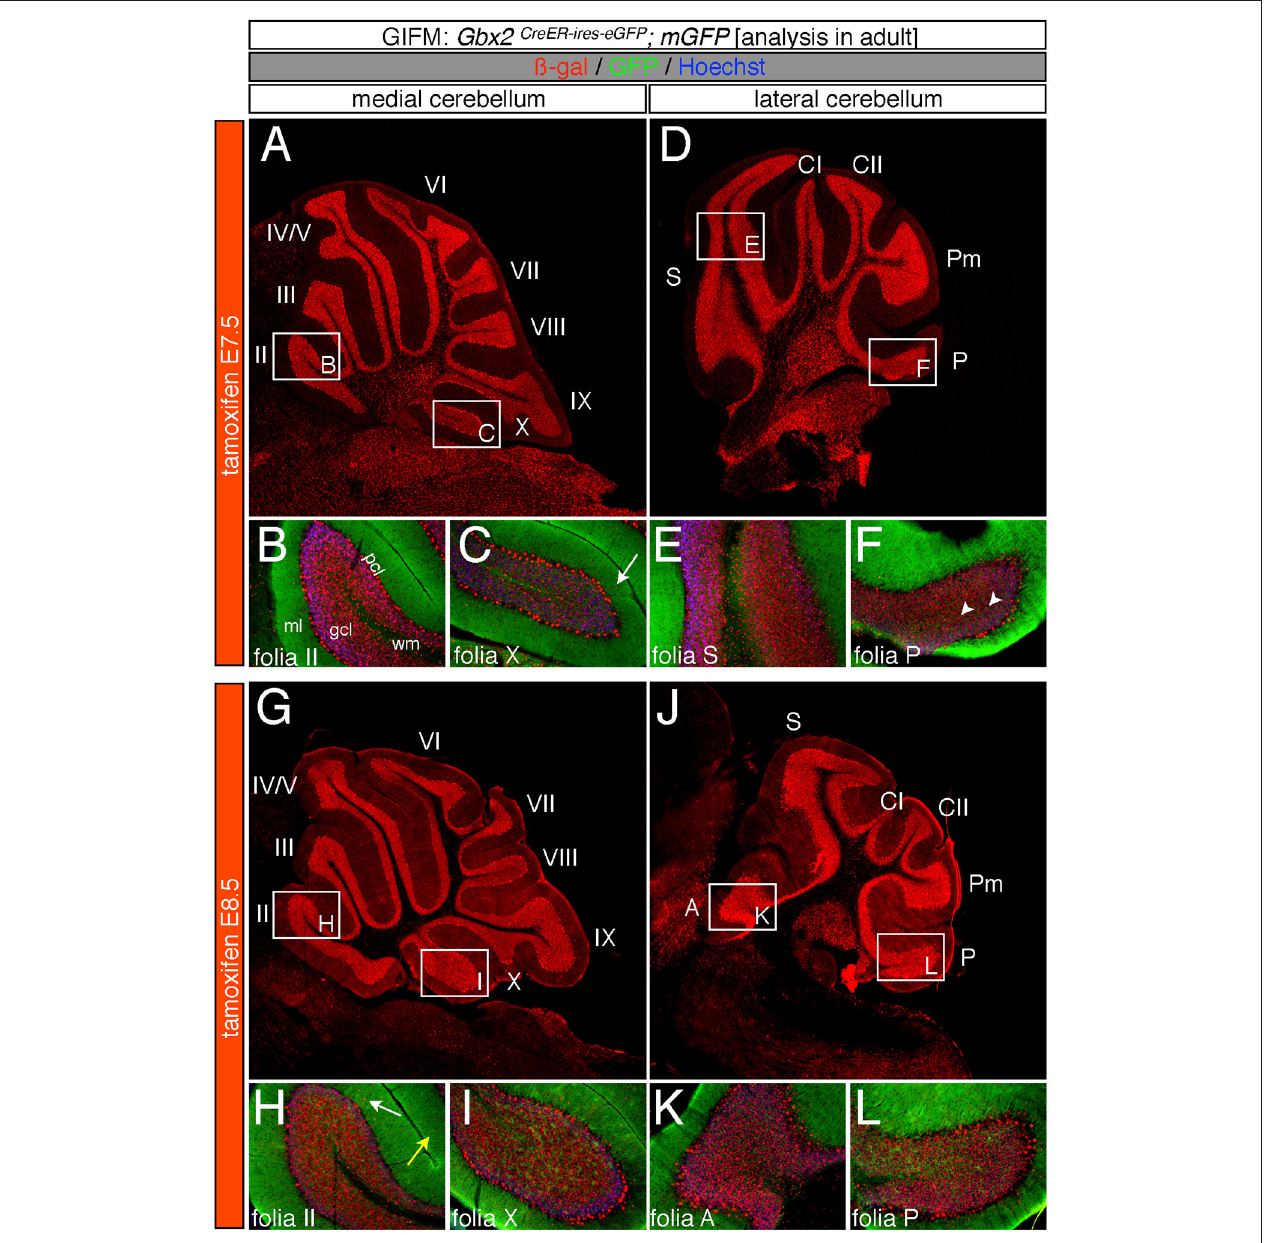
FIGURE 3 | Spatial and temporal contribution of the early marked Gbx2 lineage to the mature Cb. ICC on adult sections with antibodies that recognize ß-gal (red) or GFP (green) revealed that early Gbx2 expressing progenitors give rise to cells throughout the Cb cortex. (A–F) Gbx2 expressing progenitors marked at E7.5 substantially contributed to granule cells. Medially, Gbx2 -derived granule cells preferentially populated the most anterior folia (A–C) while laterally, the Gbx2 lineage was more evenly distributed across the Cb (D–F) . The Gbx2 lineage also gave rise to Purkinje cells at this marking stage, but the contribution was biased toward the medial posterior Cb (B,C,E,F) . (G–L) Gbx2 expressing progenitors marked at E8.5 were evenly distributed throughout the Cb and constituted the peak contribution to granule cells. Similar to marking a day earlier, Gbx2 expressing progenitors marked at E8.5 also produced Purkinje cells, particularly in the medial posterior Cb (H,I,K,L) . White arrows demarcate Gbx2-derived nuclei in the molecular layer and arrowheads indicate “intermediate cells” in the granule cell layer and white matter. Scale bars: 180 µ m (A,D,G,J) , 90 µ m (B,C,E,F,H,I,K,L) . See Supplemental Figure 2 for fate mapping summary of Gbx2 lineage contribution to granule cells when marked